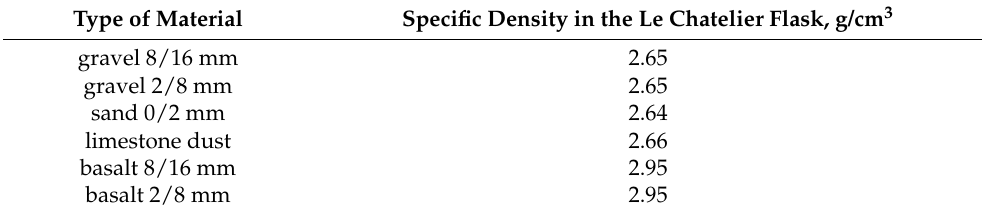
Table 9. Specific density in the Le Chatelier Flask.